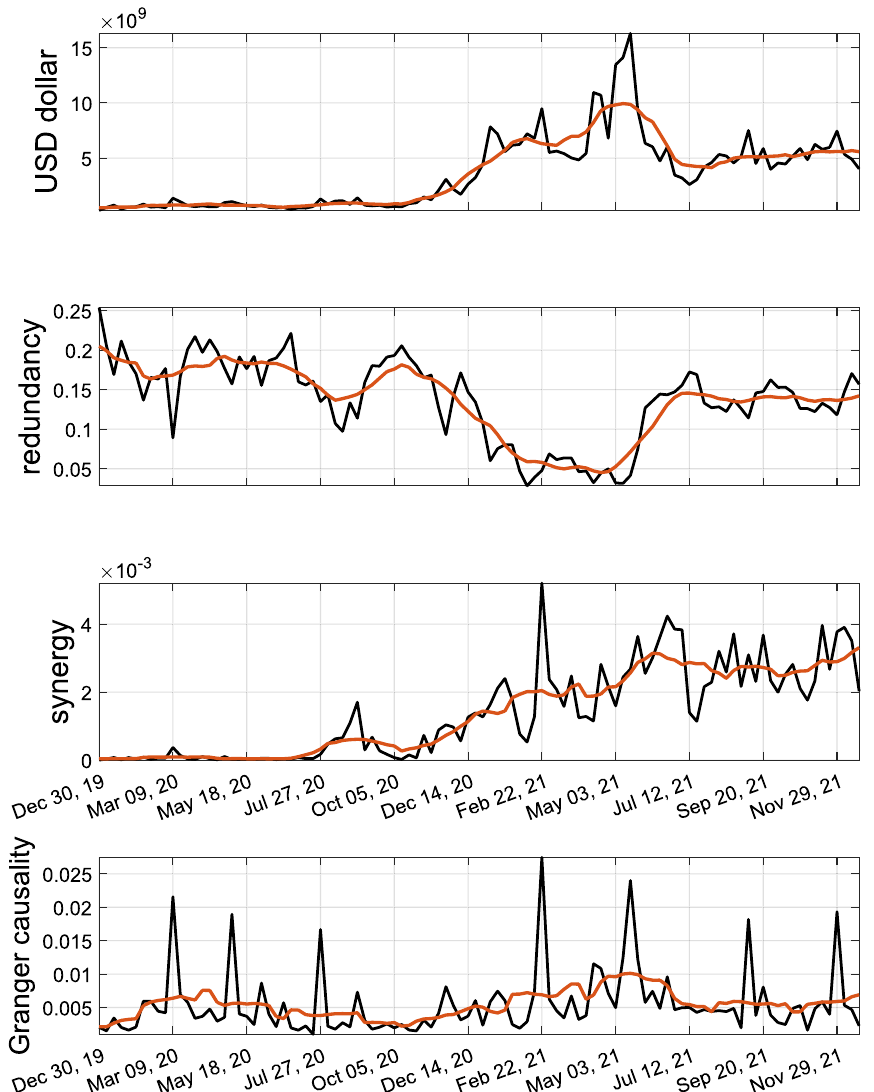
Figure 7. From top to bottom: the total volume (in US dollar) exchanged in each time window; the average value of redundancy and synergy and the average value of Granger causality F calculated for each time window. The 10-weeks moving average of the signal is represented in